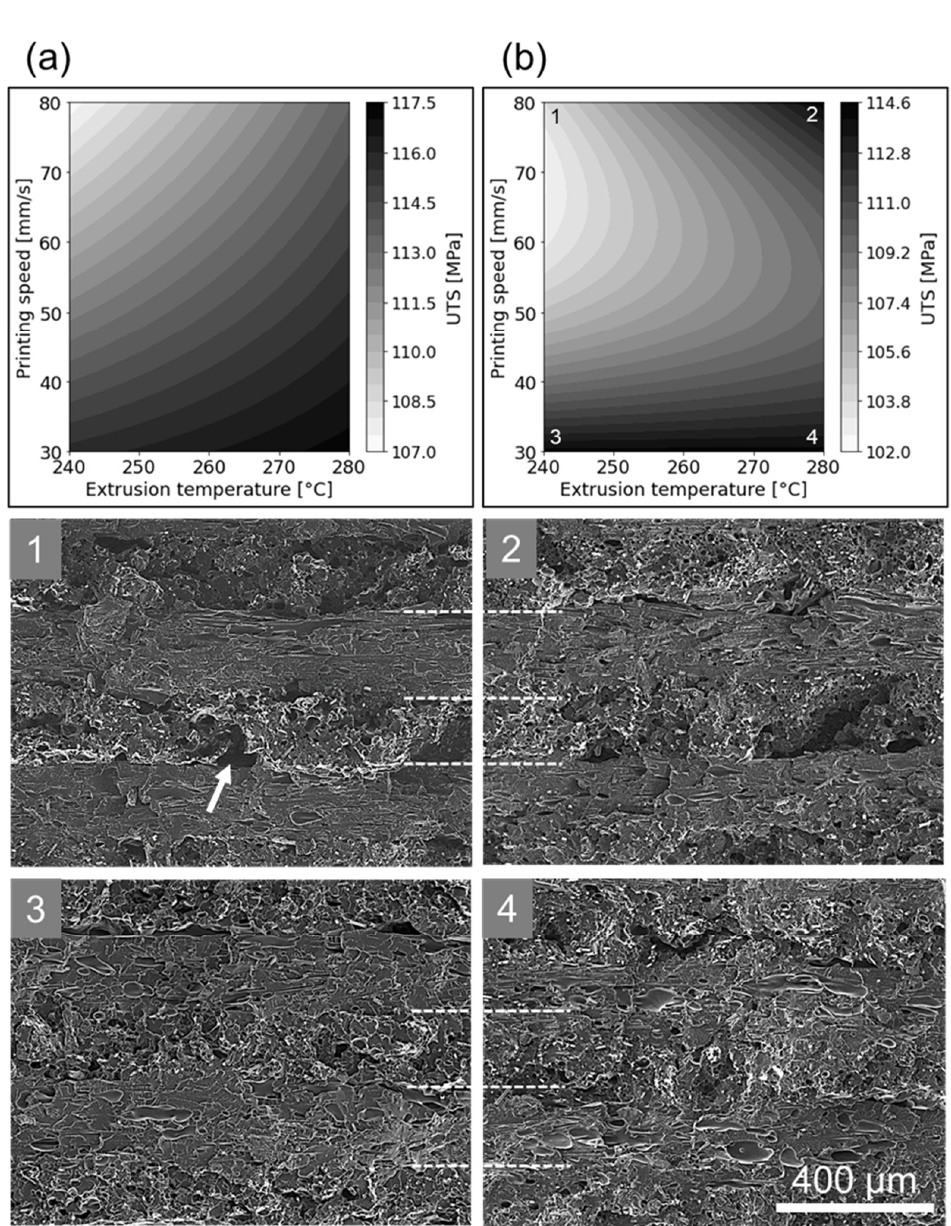
Figure 23. Contour plots for T ext and v based on the ( a ) DoE and ( b ) ML-based prediction models, with T bed and h kept at 120 °C and 0.2 mm, respectively. Fracture surfaces labeled with numerals ( 1 – 4 ) were obtained from specimens mechanically tested at FFF parameter combinations indicated in ( b ). White dashed lines in the images of fracture surfaces indicate the estimated transition between successive layers. Arrow in 1 indicates an inter-road gap.